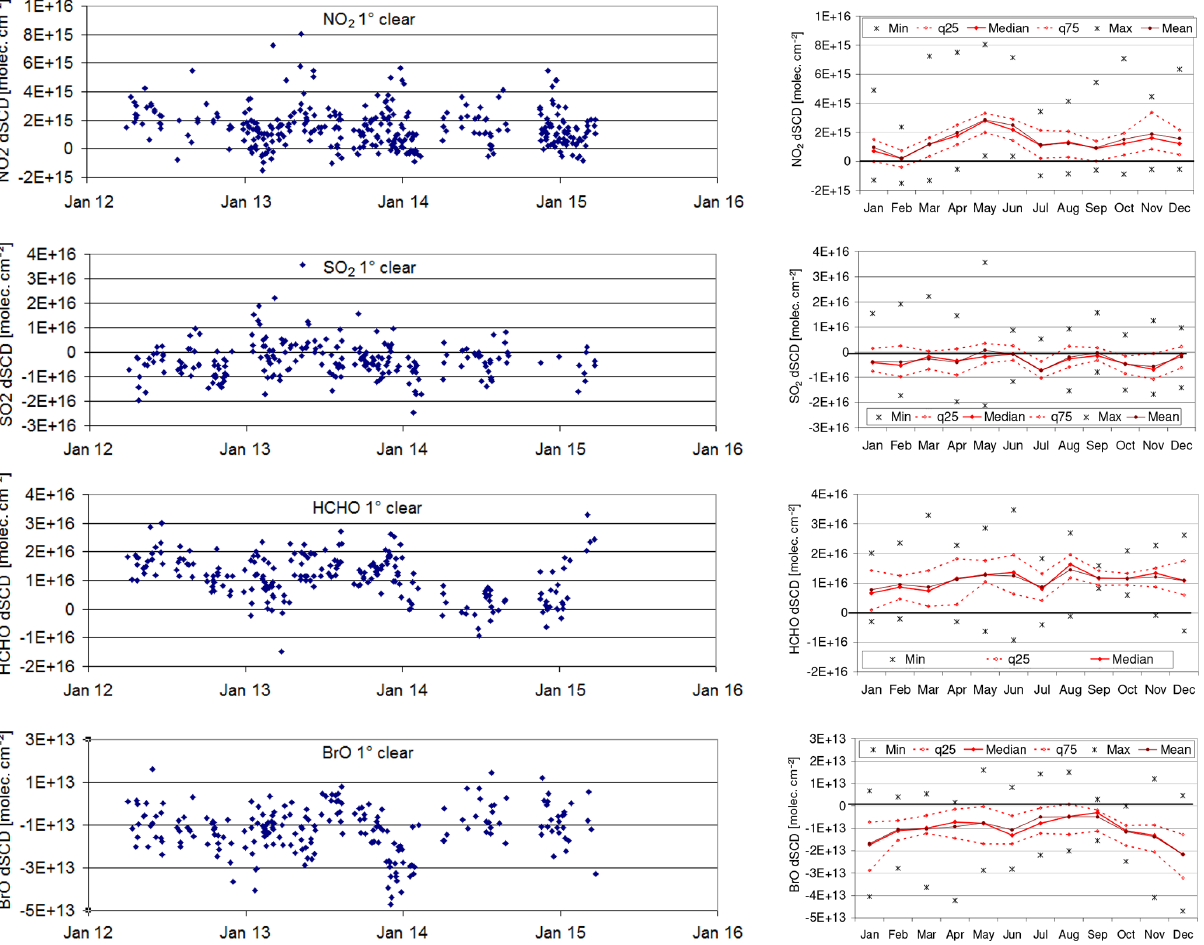
Figure 7. Left: time series of daily averaged trace gas dSCDs at 1 ◦ elevation for clear-sky spectra and low aerosol load from 2012 to 2015, with “Jan 12” referring to “1 Jan 2012”. Right: corresponding seasonal